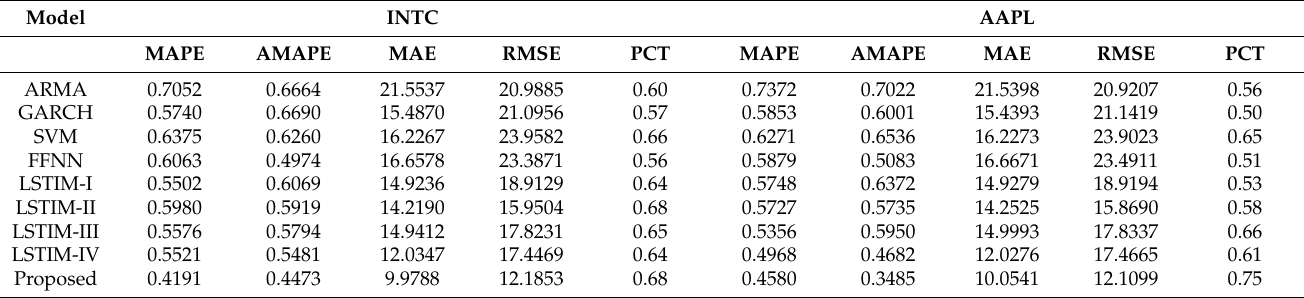
Table 5. Prediction performance for 75 days: INTC and